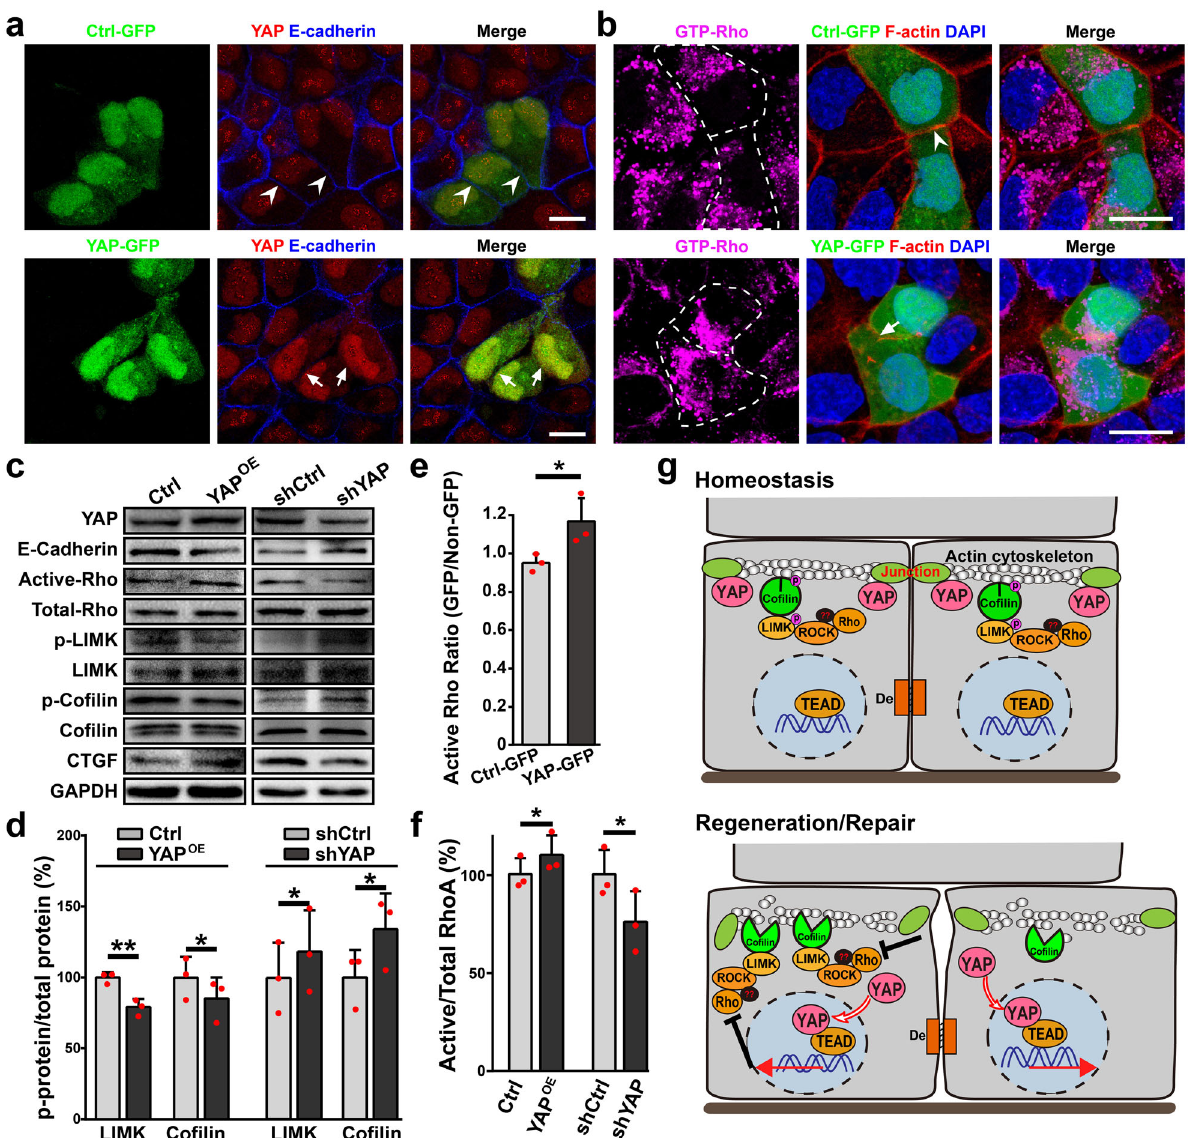
Fig. 6 YAP as a key regulator of the assembly of cell junction and cortical F-actin cytoskeleton. a YAP-overexpressing hCECs (YAP-GFP) and hCECs infected with control lentivirus (Ctrl-GFP) are co-cultured with uninfected hCECs (without GFP). YAP and E-cadherin stainings for hCECs. Arrows and arrowheads indicate present or absent E-cadherin staining, respectively, at the interface between two infected hCECs. b Staining of hCECs for active GTP-bound Rho and cortical actin cytoskeleton. The broken white lines show GFP-positive infected hCECs. Arrows and arrowheads indicate present or disrupted cortical F-actin cytoskeleton, respectively, at the interface between two infected hCECs. c Control, YAP-overexpressing hCECs (YAP-OE), shCtrl and YAP-knockdown hCECs (shYAP) are immunoblotted to evaluate RhoA activity, expressions of YAP, E-cadherin, LIMK and Co fi lin, and phosphorylation of LIMK and Co fi lin. d Quanti fi cation of p-LIMK/LIMK and p-Co fi lin/Co fi lin in control hCECs and YAP-overexpressing hCECs (YAP-OE) or YAP-knockdown hCECs (shYAP). e The GTP-bound active Rho ratio of immuno fl uorescence intensity between GFP-positive infected hCECs (Ctrl or YAP-overexpressing) and GFP-negative uninfected hCECs. f Quanti fi cation of active GTP-bound RhoA/Total RhoA in control hCECs and YAP-overexpressing hCECs (YAP-OE) or YAP-knockdown hCECs (shYAP). g Schematic representations of the reciprocal regulation of YAP activity and the assembly of cell junction and cortical F-actin cytoskeleton via the ROCK/ LIMK/Co fi lin pathway. Scale bars, 20 μ m ( a , b ). Data are the mean ± SD, n = 3 experiments ( d , f ), n = 3 fi elds ( e ); * p < 0.05, ** p < 0.01; Student ’ s two-tailed paired t -test ( d , f ) or unpaired t -test ( e